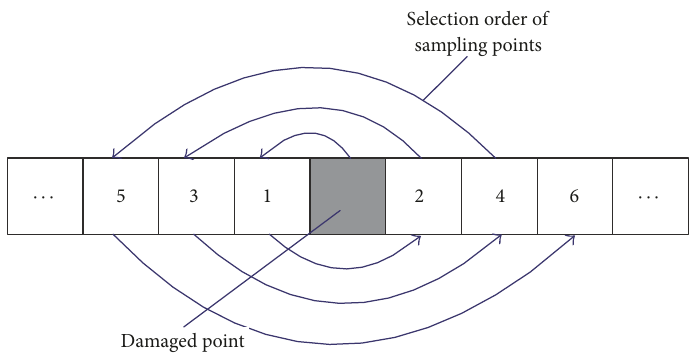
Figure 2: Selection of sampling points.